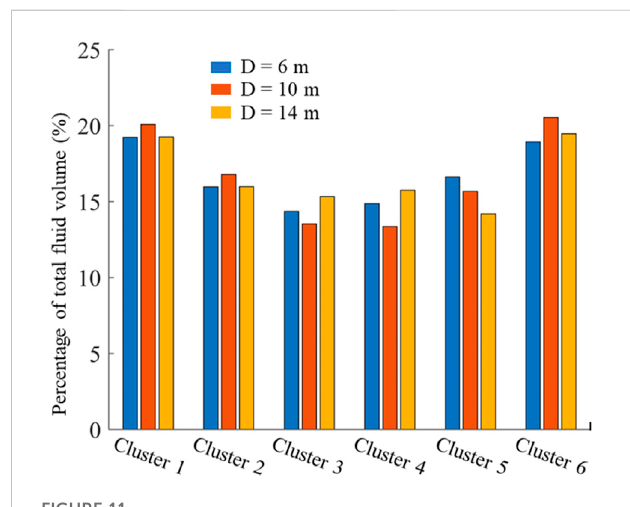
FIGURE 11 The total fl uid volume distribution of each cluster for three cases with different cluster